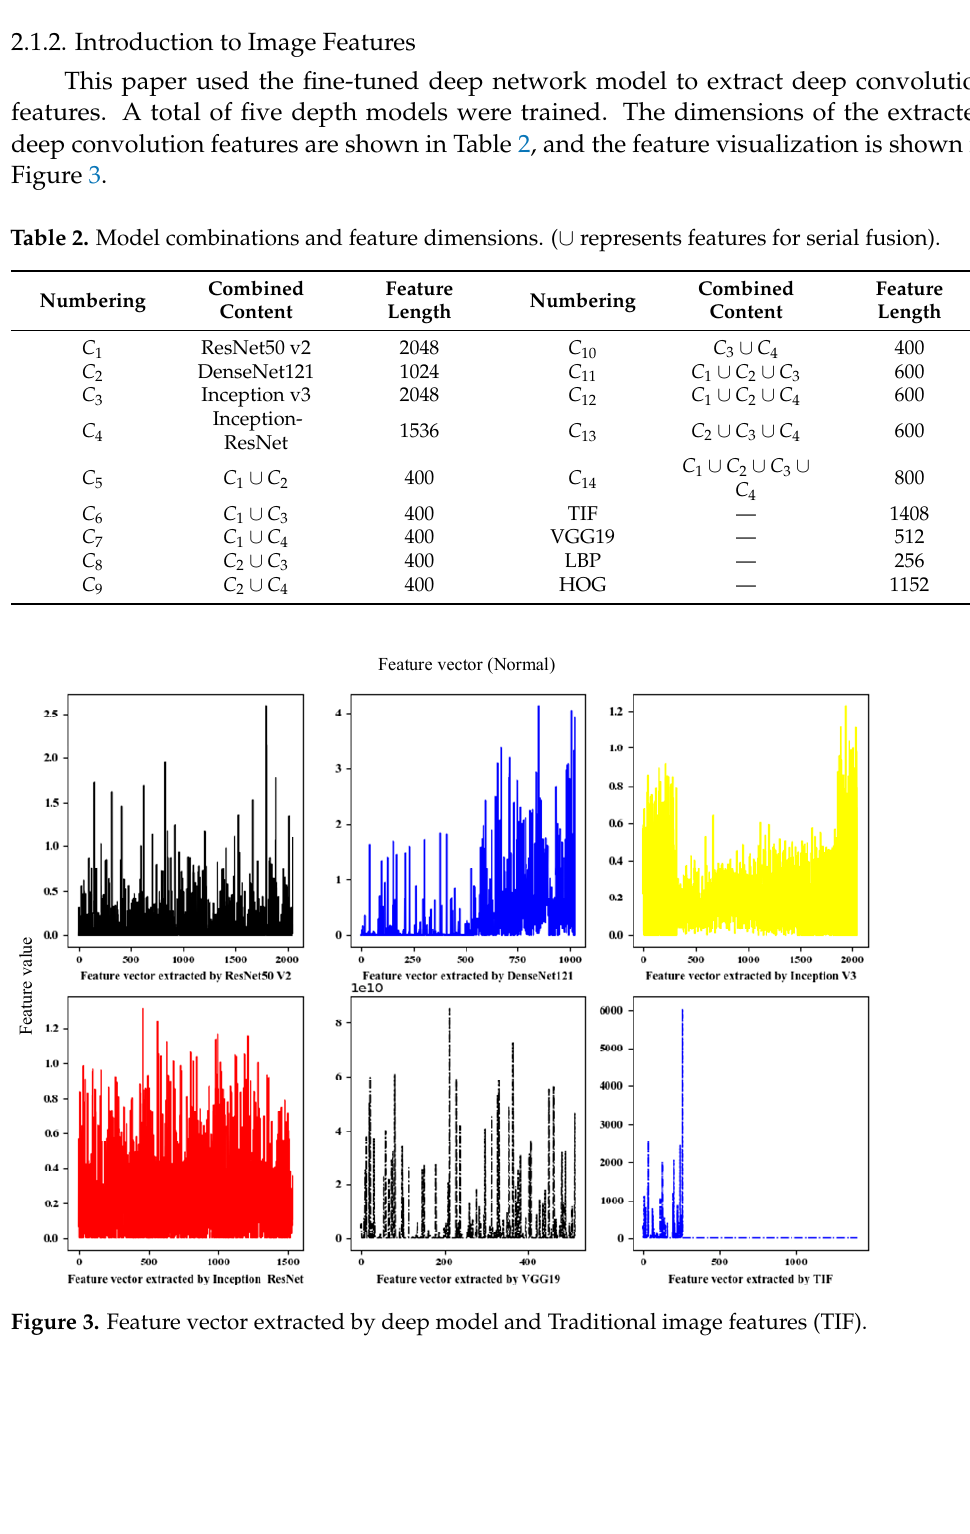
Figure 4. Diagram of the local binary pattern (LBP) descriptor calculation process. HOG [32,33] features have a strong image structure and contour description capabil- ities as well as a strong recognition effect on the description of local areas. HOG features are also suitable for describing texture features. Texture features have local irregularity and macro regularity. Using appropriate HOG cell units to divide the image and extract- ing HOG features can obtain the changing pattern of the overall texture features of the image. Choosing HOG cell units that are too small results in local features that are too fine and macro features that are unclear and computationally complex. If the selected HOG cell unit is too large, the local feature description is incomplete, which is not conducive to generalizing the macro features. The cell unit size used in this paper was 10 × 10.